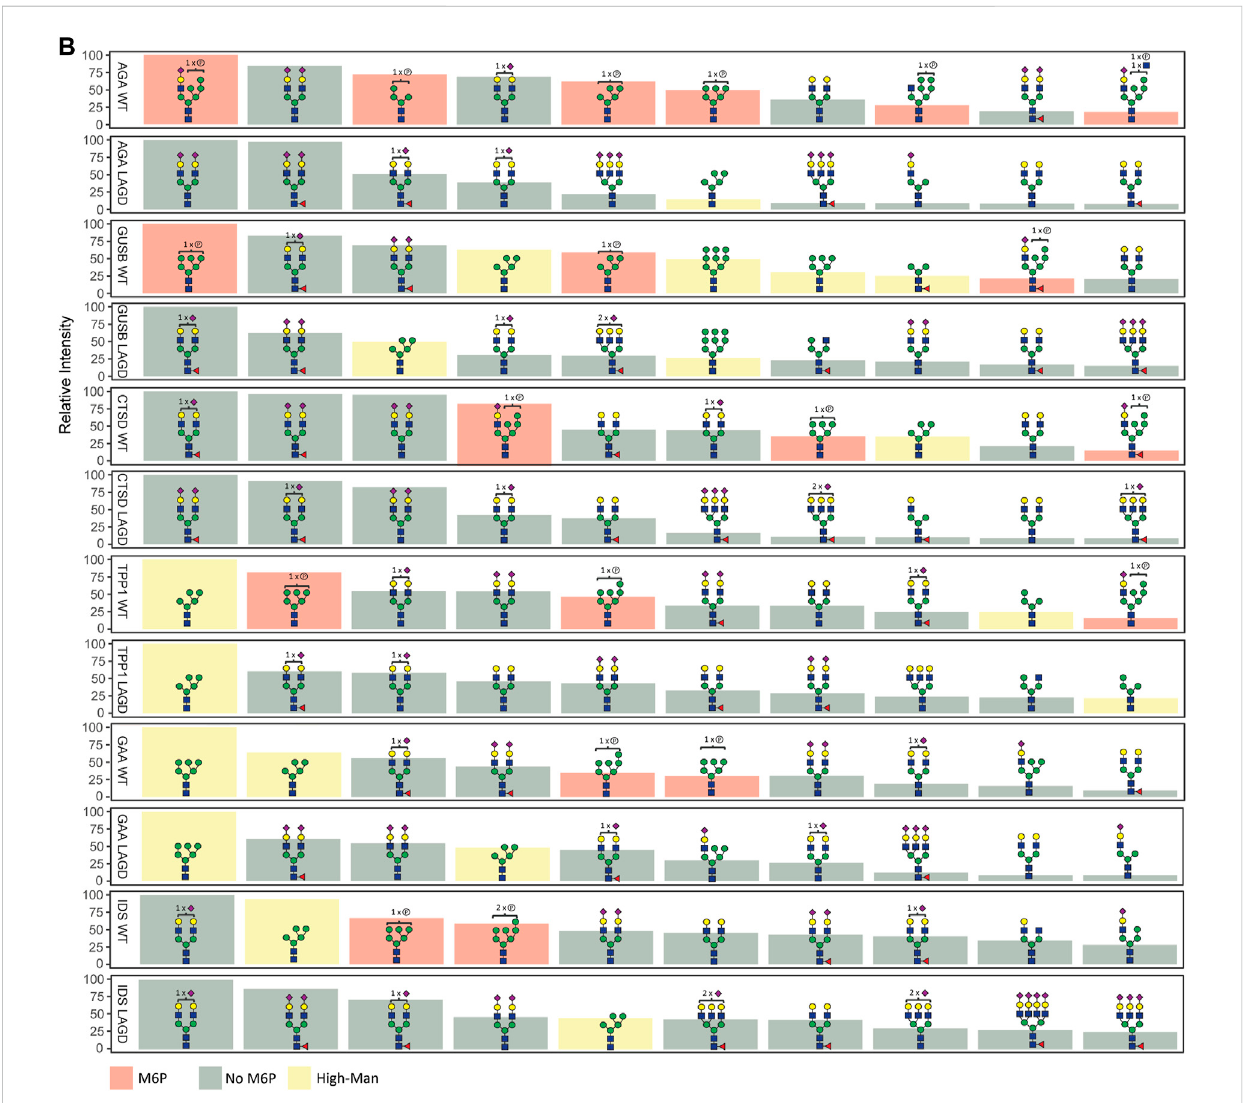
FIGURE 3 N-glycan analysis of puri fi ed recombinant lysosomal enzymes (AGA, GUSB, CTSD, TPP1, GAA, and IDS) produced in CHO WT and engineered CHO cells. (A) Summaryofsite-speci fi cN-glycopeptideanalysis ofpuri fi edrecombinantlysosomalenzymes(AGA,GUSB,CTSDandGAA)producedinCHO WT and engineered CHO cells. The most abundant glycan structure at N-glycosites of each enzyme produced in CHO WT and engineered CHO clones are displayed on the top and bottom panels, respectively, with arrows indicating genetic editing strategy. Question mark indicates that no site-speci fi c glycan structure was obtained for the partucular site. All glycan structures at each glycosite were con fi rmed by tandem mass spectrometry (MS/MS) analysis. (B) Summary of released Rapi Fluor-labeled N-glycan pro fi ling showing the ten most abundant predicted species (normalized to most abundant